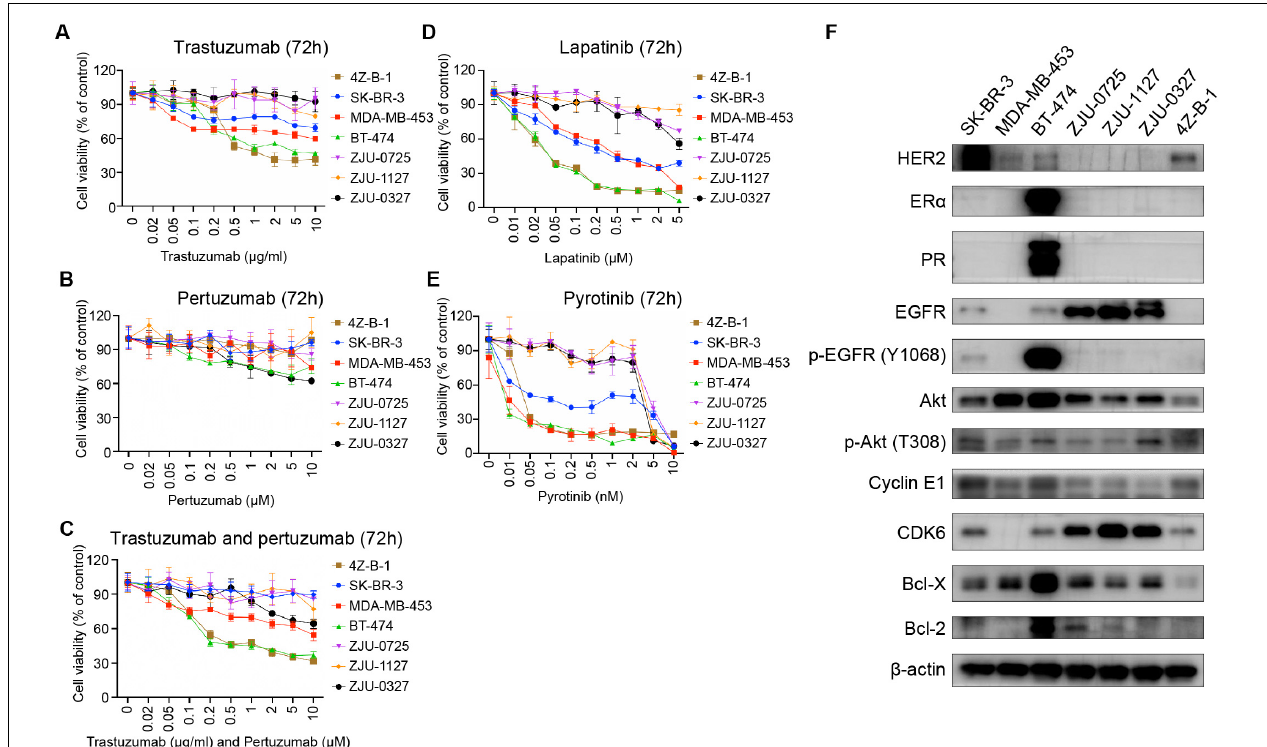
FIGURE 4 | Sensitivity to HER2-targeting agents and expression of associated proteins. (A–E) Comparison of sensitivity to trastuzumab, pertuzumab, the combination of trastuzumab and pertuzumab, lapatinib and pyrotinib between the 4Z-B-1 cell line and other HER2-positive breast cancer cell lines. (F) Expression of HER2-targeting agent sensitivity-associated genes in the 4Z-B-1 cell line and other HER2-positive breast cancer cell